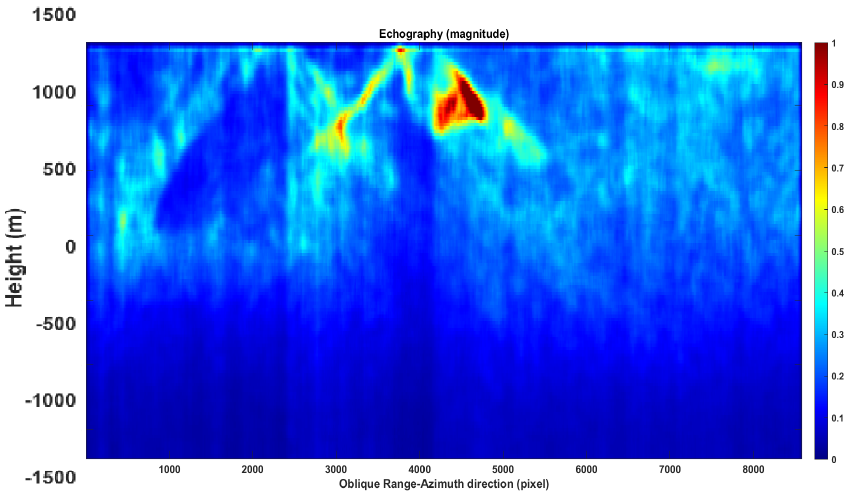
Figure 12. Range-azimuth line echographic tomography result